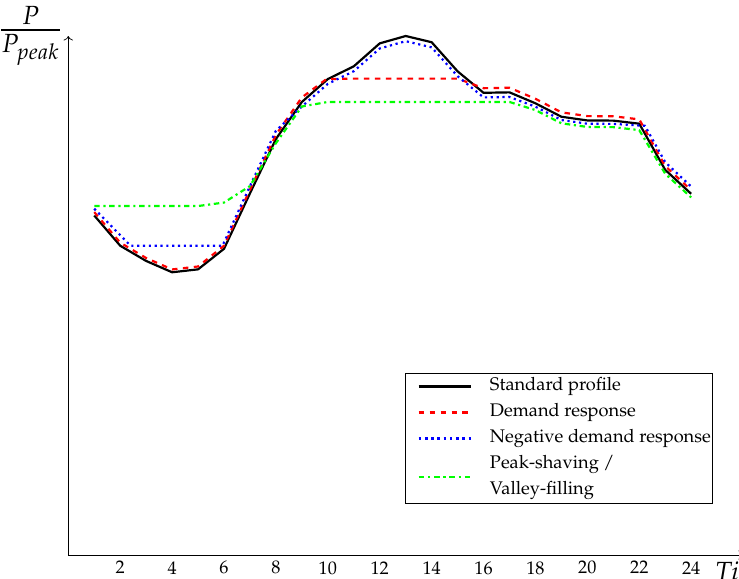
Figure 2. The effects of applying G2V strategies on demand